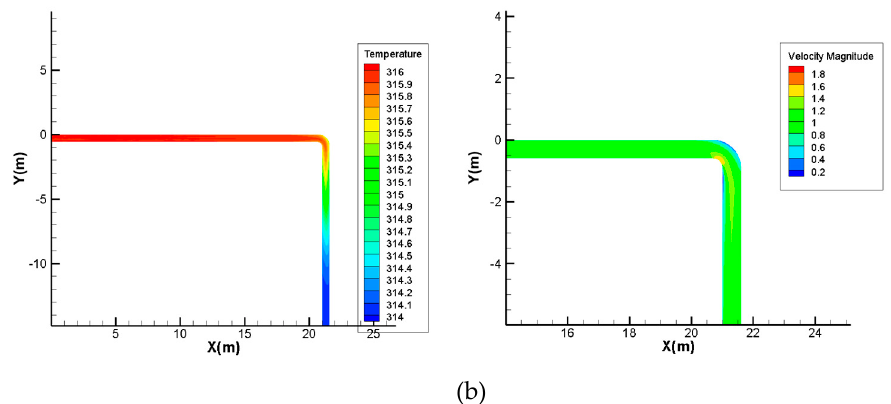
Figure 5. (a) Temperature contours and velocity contours in 1 st order upward; (b) Temperature Figure 5. ( a ) Temperature contours and velocity contours in 1 st order upward; ( b ) Temperature contours contours and velocity contours in 2 nd order upward. and velocity contours in 2 nd order